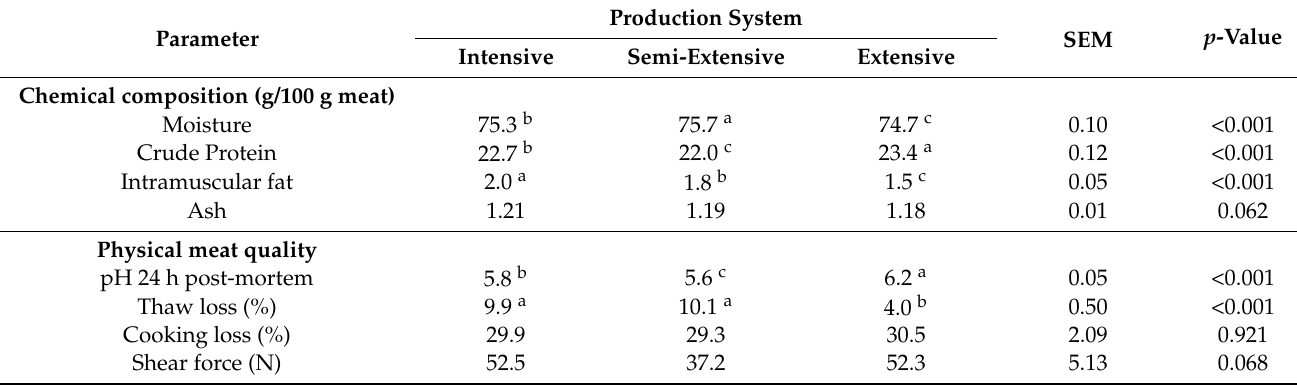
Table 4. LSMeans and the pooled standard error (SEM) of the chemical and physical parameters of sub-adult male impala longissimus thoracis et lumborum meat as influenced by production system. A total mixed ration was fed in the intensive system ( n = 12), while supplementation (with the same ration) was provided on Savanna vegetation ( n = 12), and no supplementation was provided to the extensive system on Renosterveld vegetation ( n =